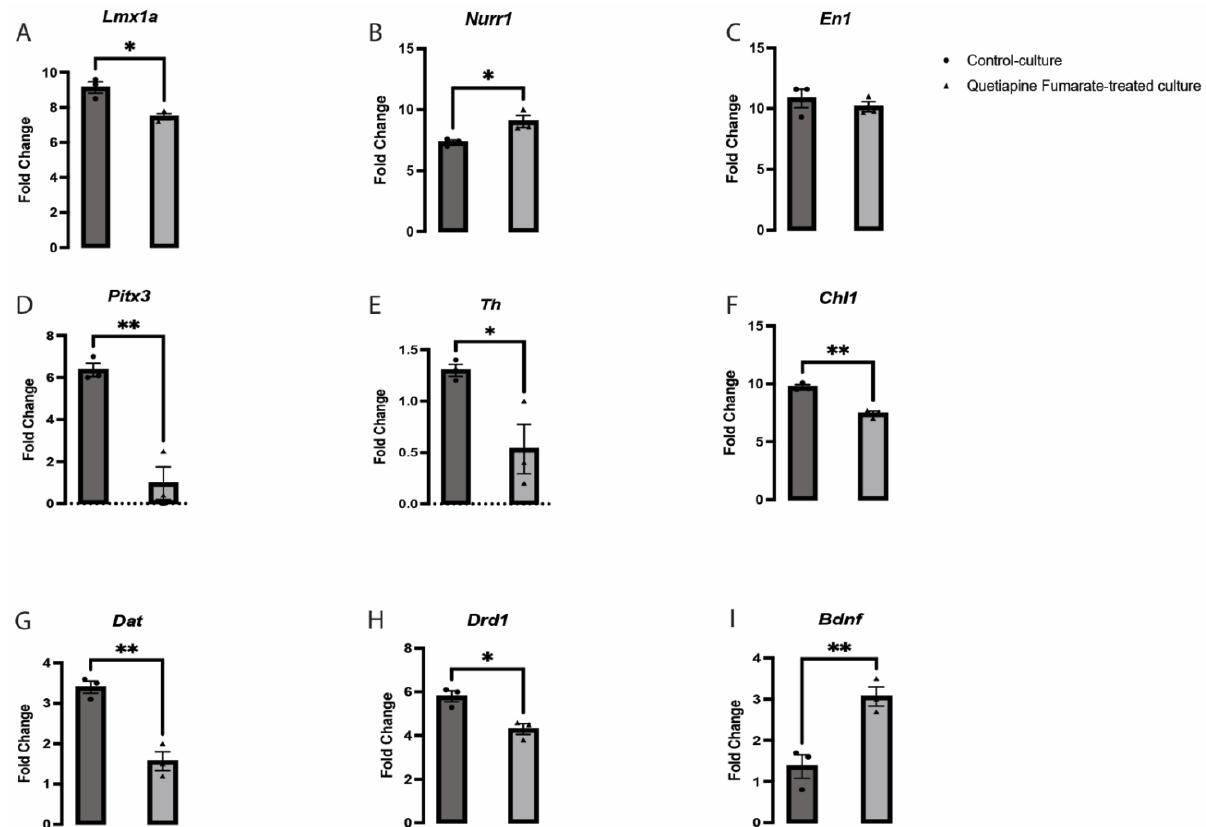
Figure 4. QEPF exposure caused a significant change in the expression of various dopaminergic VM-related genes. The expressions of Lmx1a ( A ), Nurr1 ( B ), Pitx3 ( D ), Th ( E ), Chl1 ( F ), Dat ( G ), Drd1 ( H ), and Bdnf ( I ) were altered by the exposure to QEPF. However, the expression of En1 ( C ) was not affected by QEPF exposure. Data are represented as mean ± SEM, n = 3 technical replicates, 3 biological replicates. * p < 0.05, ** p < 0.01.